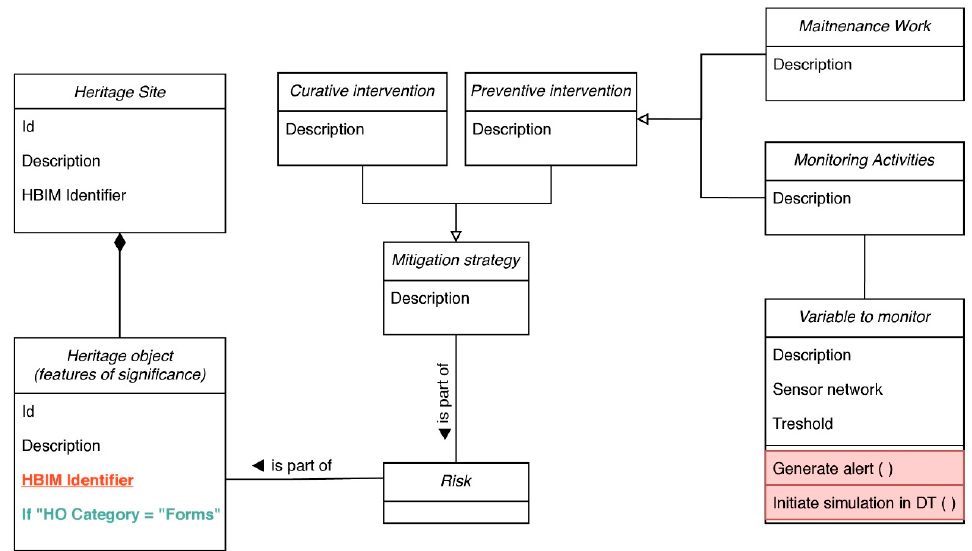
Figure 11. Initiation of simulation processes in DT through alert generation based on the monitoring of specific variables to monitor processes of deterioration or allow the early detection of hazards. The alert is generated after reaching the defined thresholds.